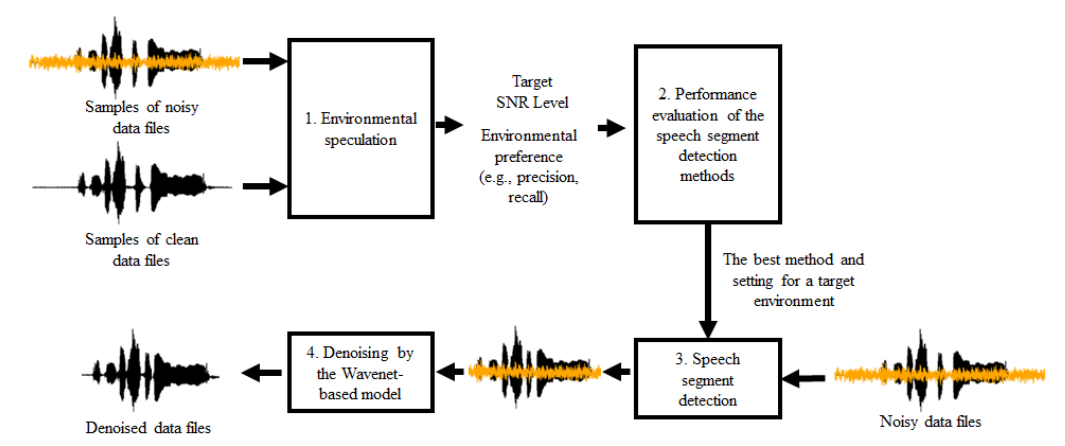
Figure 2. The concept of the proposed preprocessing strategy for